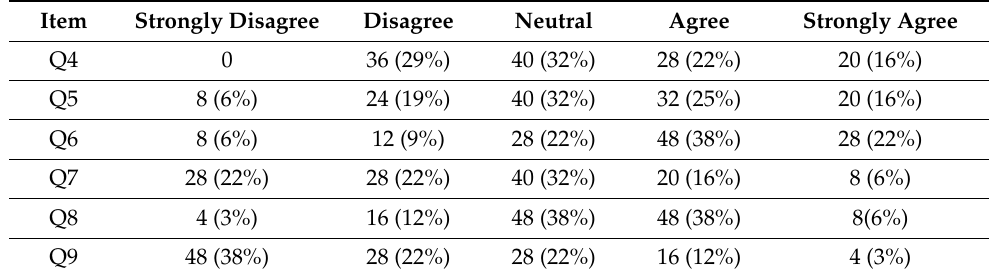
Table 9. Frequency distribution table for items regarding the attention paid to emotional messages.